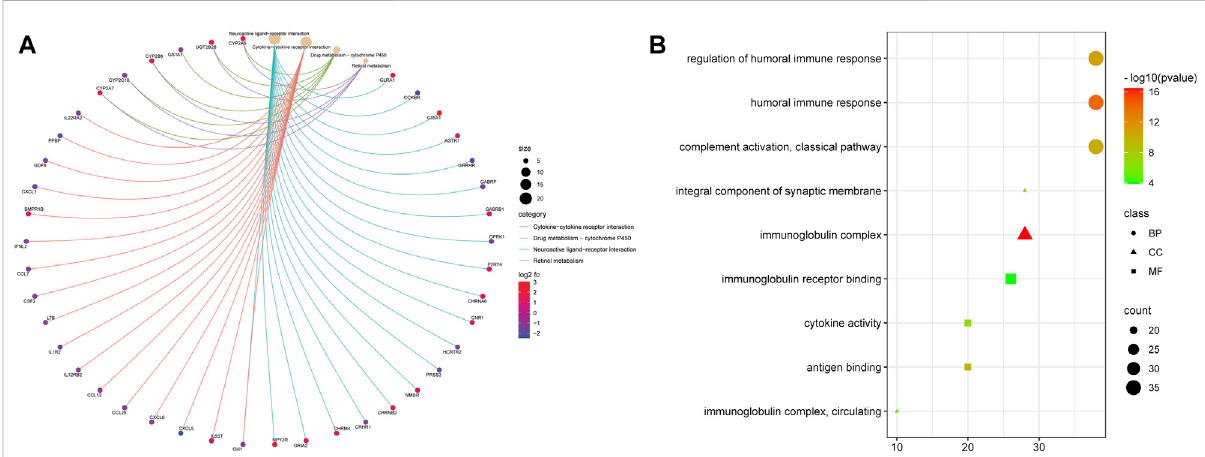
FIGURE 5 FunctionalanalysisbasedontheDEGsbetweenthetworiskgroups. (A) BubblegraphforGOenrichment(thebiggerbubblemeansmoregenes are enriched, and the increasing depth of red means the differences were more obvious. (B) Cnetplot for KEGG pathways.